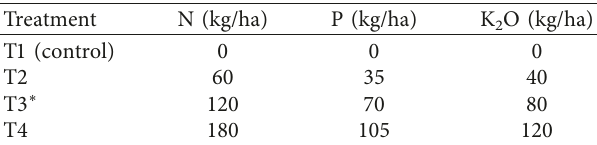
Table 1: Nitrogen, potassium, and phosphorus rates for each treatment.